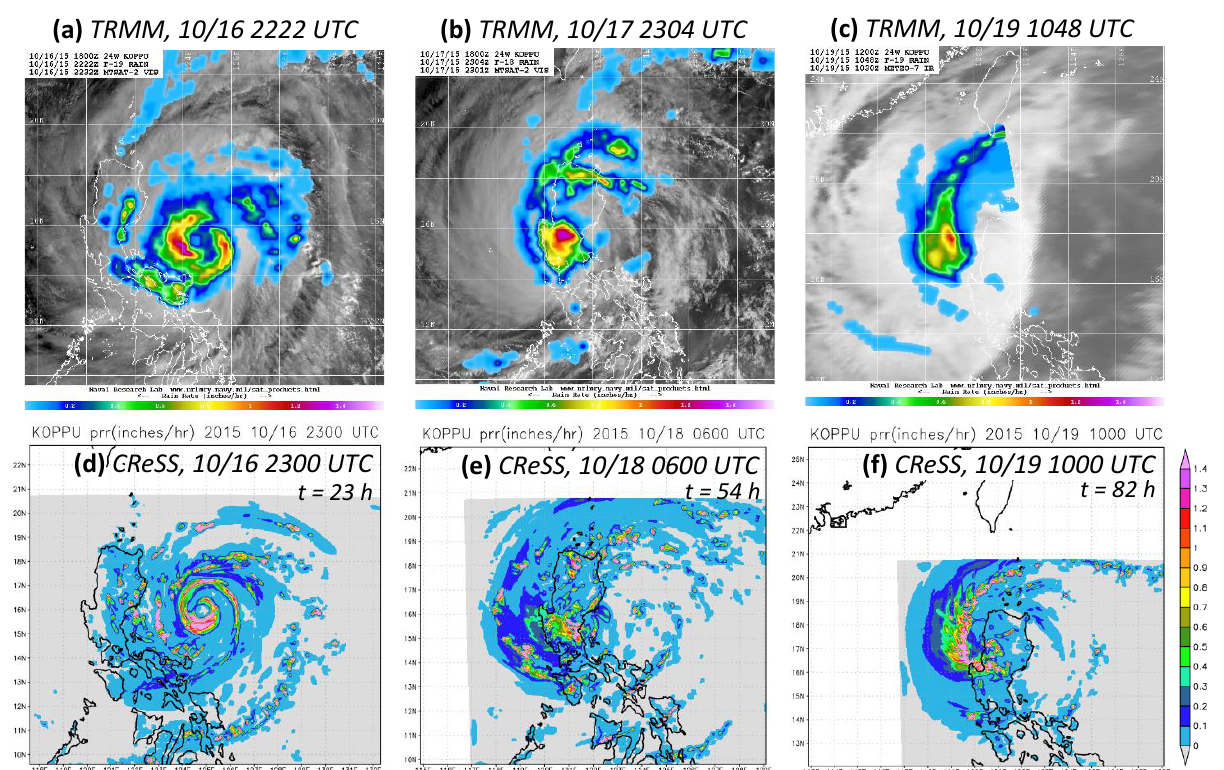
Figure 7. TRMM rainrate retrieval (inch h − 1 , color), overlaid on visible (or infrared) cloud imagery of the MTSAT-2 (or Meteo-7) satellite at closest time, of TY Koppu (2015) at ( a ) 2222 UTC 16, ( b ) 2304 UTC 17, and ( c ) 1048 UTC 19 October (source: NRL), and model rainrate (inch h − 1 , color) valid at ( d ) 2300 UTC 16, ( e ) 0600 UTC 18, and ( f ) 1000 UTC 19 October from the forecast initialized at 0000 UTC 16 October 2015 (forecast hour labeled). The region plotted and color scale used are similar for each pair.